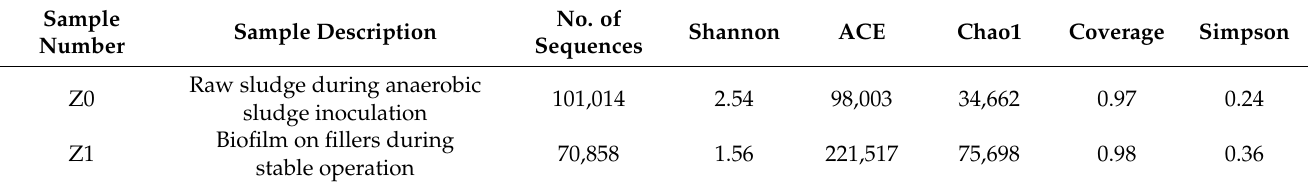
Figure 4. Scanning electron microscopy (SEM) results of microbial communities in biofilms. ( A ) Microbiological phase on the filler surface after aerobic suspension, 5.00 k. ( B ) Microbiological phase on the filler surface after aerobic suspension, 10.00 k. ( C ) Microbial phases on the filler surface of the reactor during stable operation, 5.00 k. ( D ) Microbial phases on the filler surface of the reactor during stable operation, 10.00 k. Table 4. Differences in the diversity indexes of archaea in the Z0 and Z1